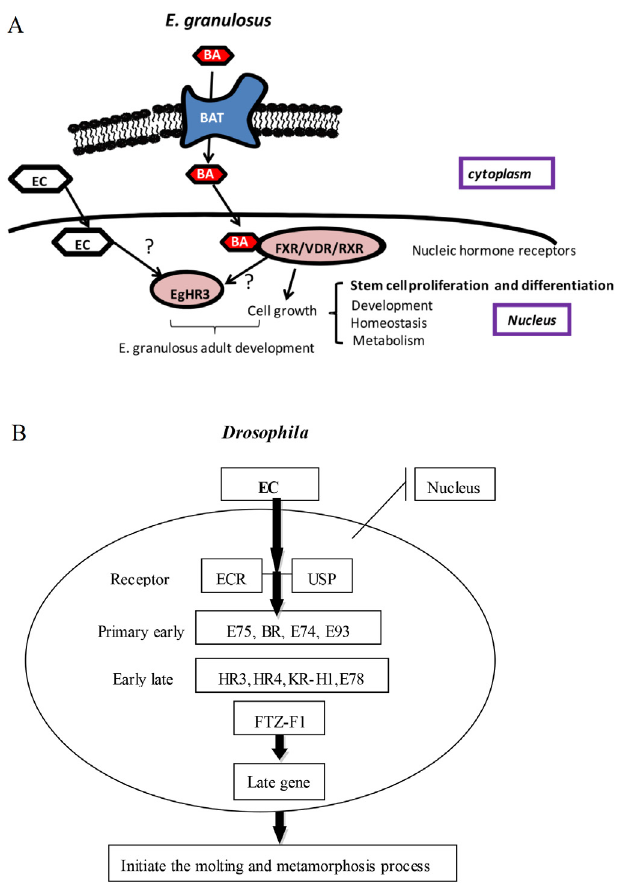
Figure 8. Summary of the ecdysone regulatory cascade. Sum- mary of the putative regulatory cascade of E. granulosus adult worm development (A). Bile acid (BA) is transported into the cytoplasm, and is then transported into the nucleus where it binds FXR/DVR/RXR to stimulate cell proliferation and growth. The BA-FXR/RXR complex or EC (ecdysone) may also regulate the transcriptional activity of EgHR3 to regulate adult worm development. Summary of the ecdysone regulatory cascade, with the 11 transcription factors known to act as classic early regulators duringtheonset of Drosophila metamorphosis (B) [12,13,37].Large black bands indicate the known protein – protein